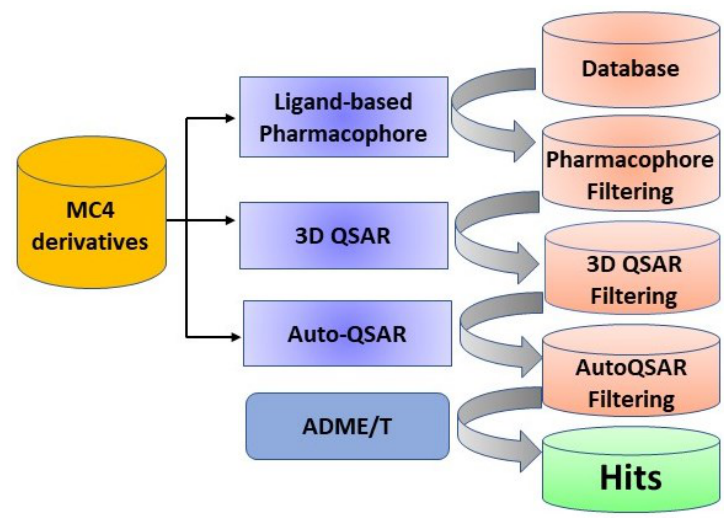
Figure 2. The workflow of current research.